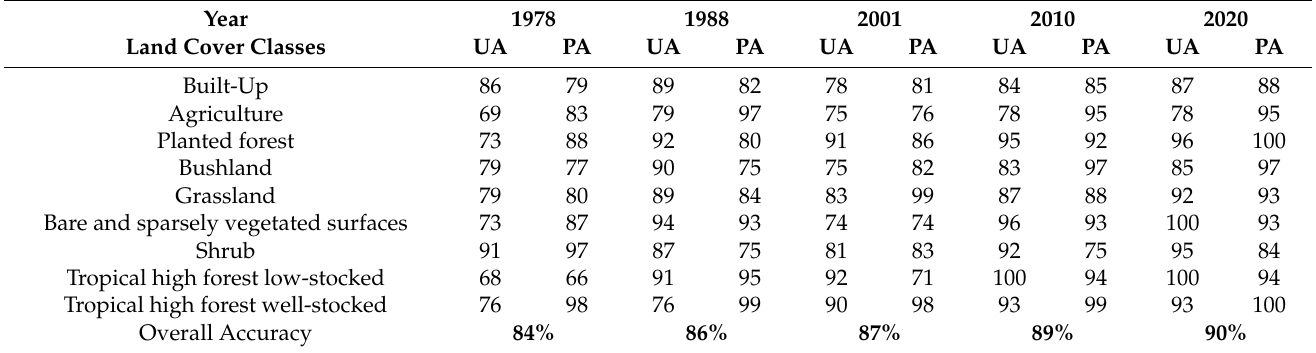
Table 3. Classification accuracy assessment of the land cover maps obtained from Landsat satellite data at the upper Manafwa watershed for the selected years